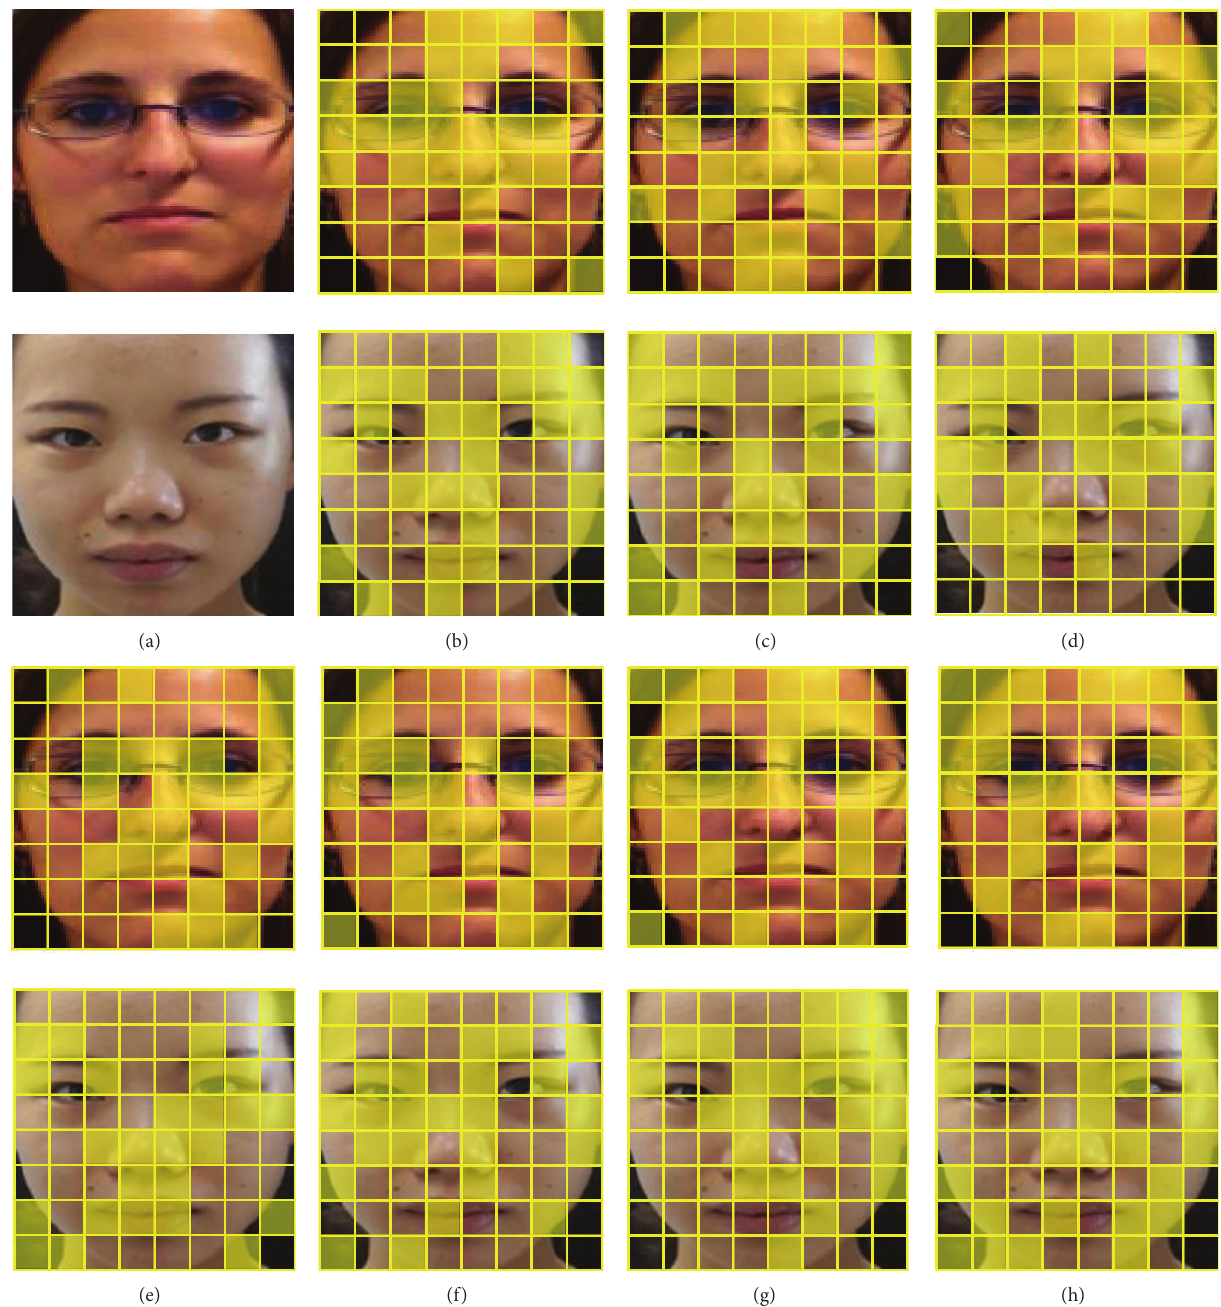
Figure 5: Examples of selected discriminative patches using proposed patches selection methods. Top row of (a)–(h), face from REPLAY- ATTACK database. Bottom row of (a)–(h), face from CASIA-FASD database. A normalized face image (a) of a subject and the discriminative selected patches using (b) CS, (c) DEND-CLUSTERING, (d) IPI, (e) IQA, (f) CP, (g) MAXDIST, and (h) DF